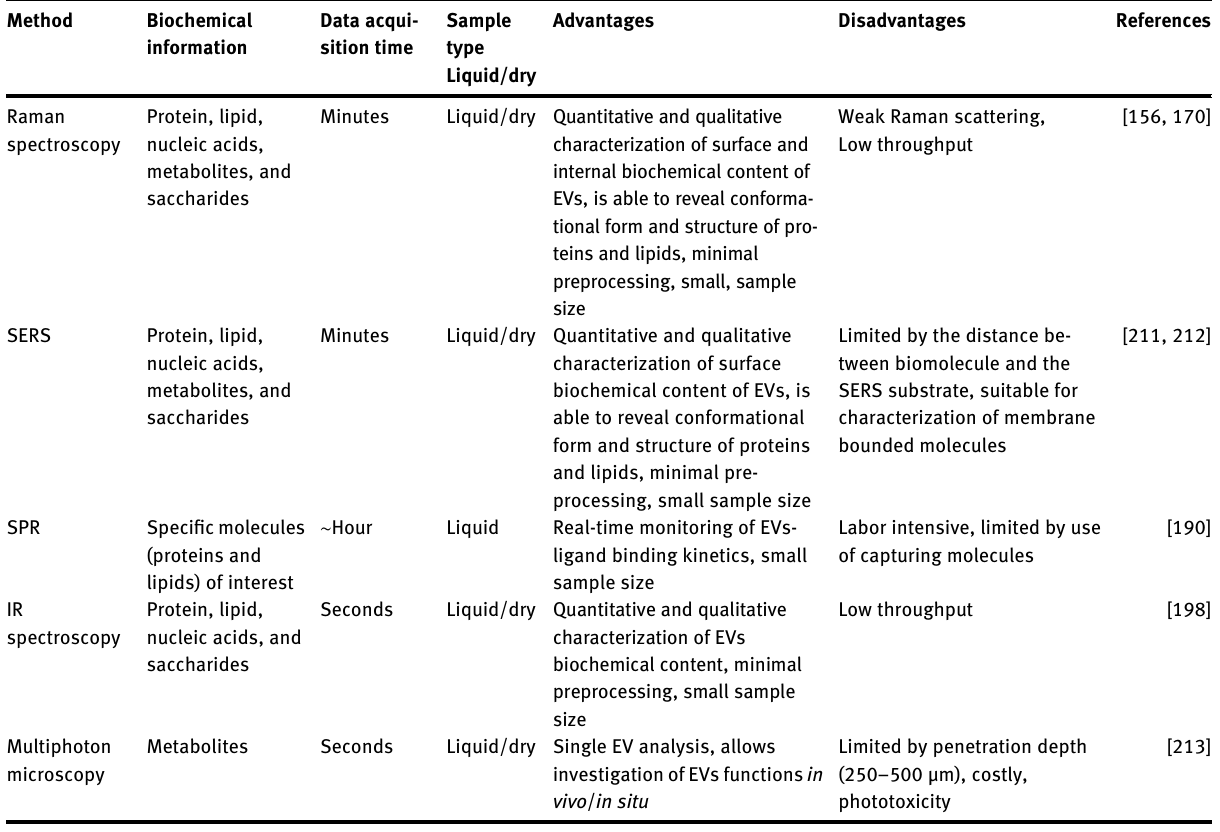
Table  : Summary of label-free optical methods for EVS biochemical composition characterization.